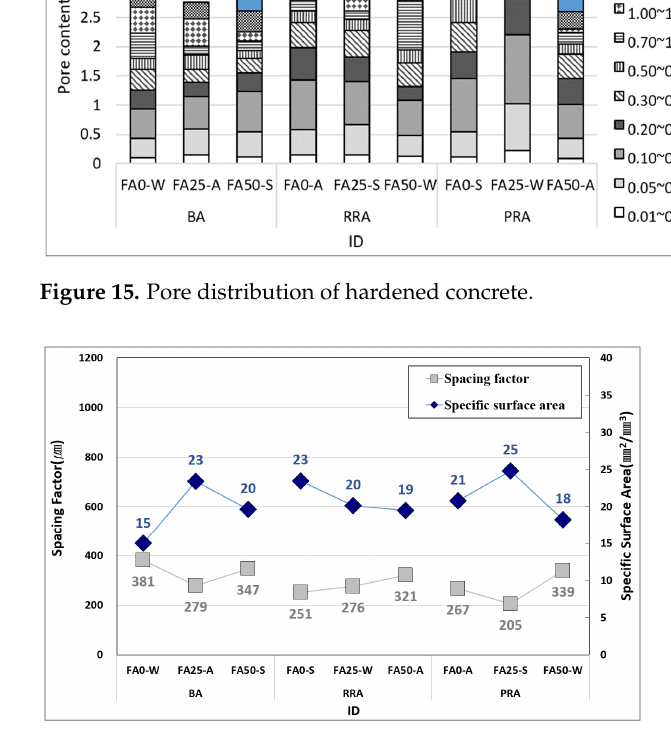
Figure 16. Spacing factor and specific surface area of concrete.